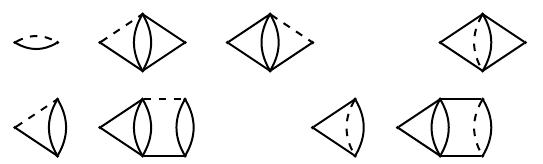
Figure 12 . Top row, from left to right the graphs [ (cid:15) H (cid:15) ] ; [ (cid:15) HS 1 ] ; [ S 1 H (cid:15) ] and [ (cid:15) V (cid:15) ]. Bottom row, from left to right [ (cid:15) HU 1 ] ; [ S 1 HU 1 ] and [ (cid:15) V ] ; [ S 1 V